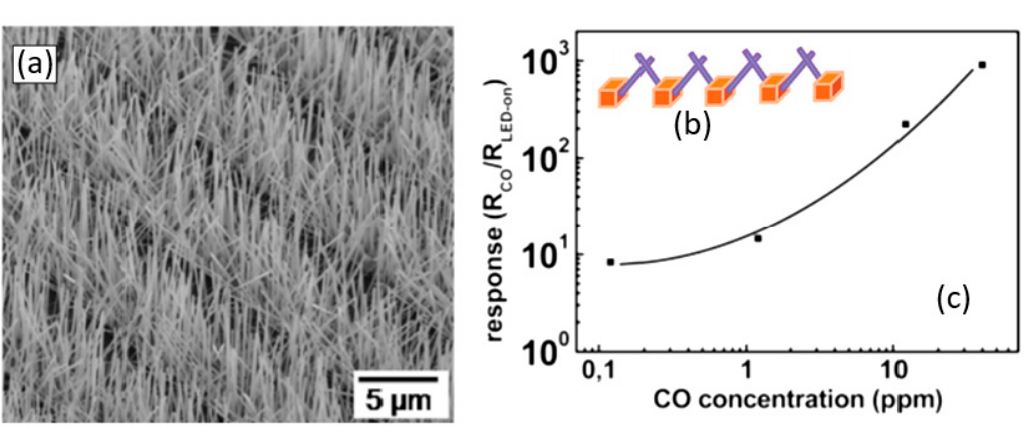
Figure 31. ( a ) SEM images of ZnO NWs grown on substrates with the Au electrodes (electrode line width × gap distance = 3 × 5 µ m); ( b ) schematic representation of the nanobridge junctions formed and ( c ) sensor response to the CO gas. Reproduced with permission from Yuon et al. [313]. Copyright 2010: American Chemical Society.